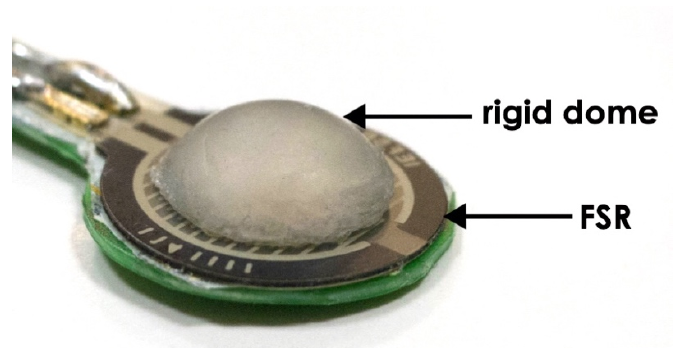
Figure 1. Force-sensitive resistor (FSR)-based forcecardiography (FCG)